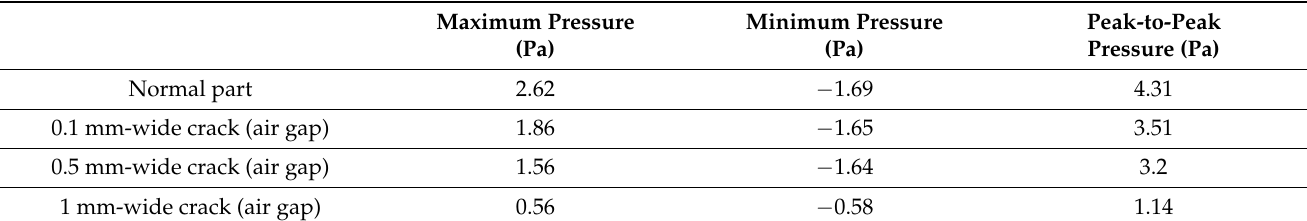
Table 2. Maximum pressure, minimum pressure, and peak-to-peak pressure of normal parts and cracked parts with various crack